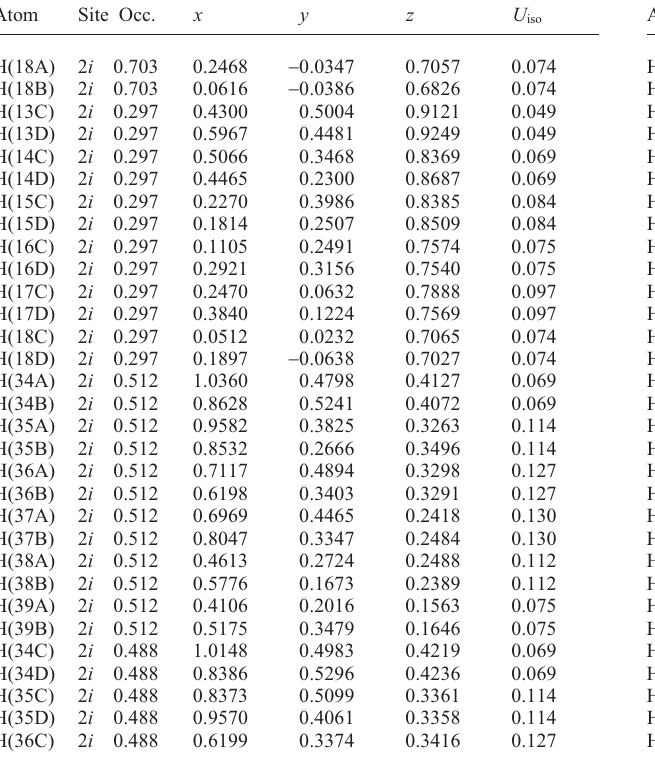
Table 3. Atomic coordinates and displacement parameters (in Å 2 )